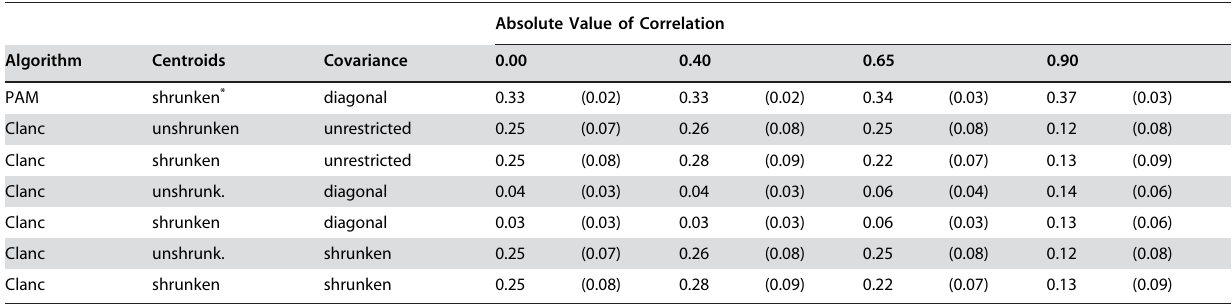
Table 4. Test error rates (standard errors): Classes not equidistant. .. ... .... ... ... .... ... ... .... ... ... .... ... ... .... ... ... .... ... ... .... ... ... .... ... ... .... ... ... .... ... ... .... ... ... .... ... ... .... ... ... .... ... ...